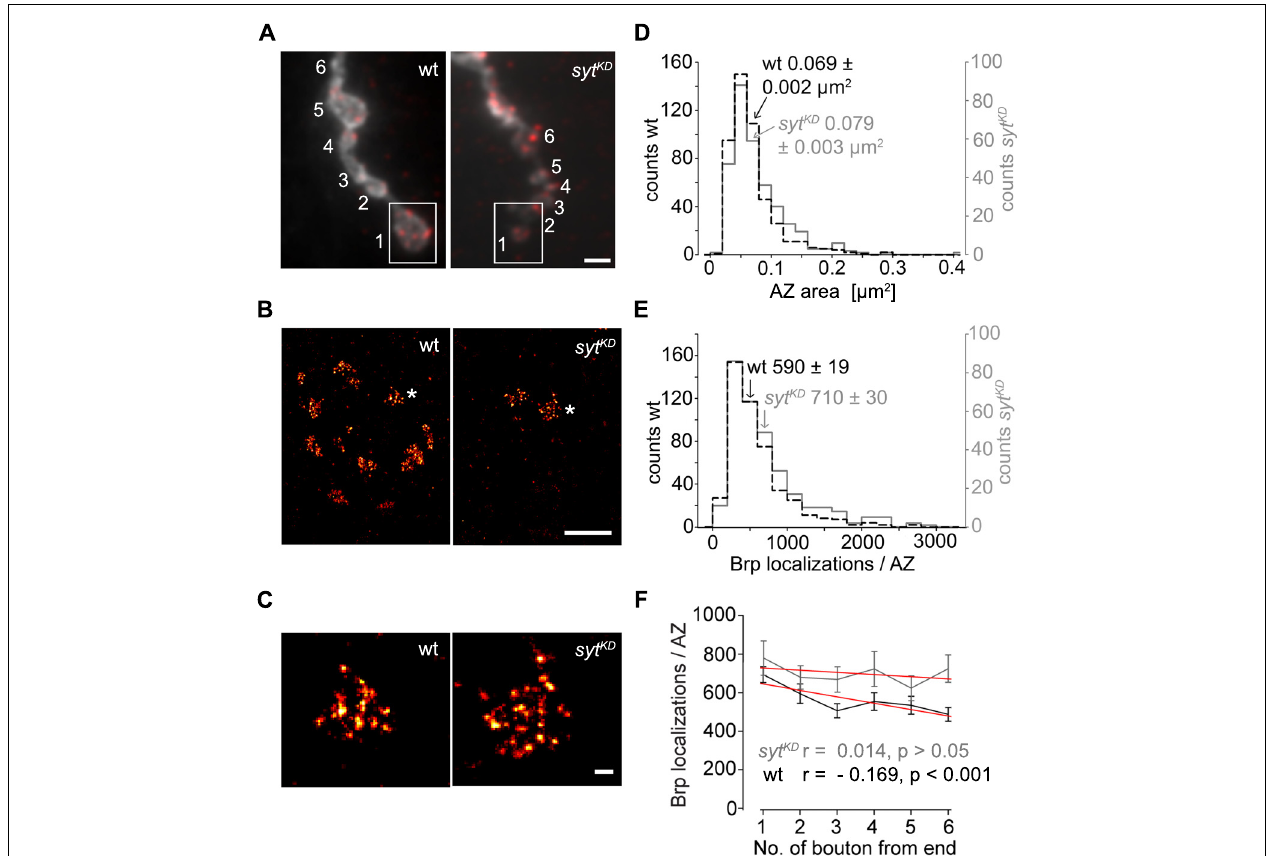
AZ areas and (E) distribution of Brp localizations per AZ are shifted to larger values in syt KD (gray). Arrows indicate respective mean ± SEM values. (F) Linear fits (red) of mean ± SEM Brp localizations per AZ in the terminal six type Ib boutons had slopes of –33.2 (wt) and –11.2 ( syt KD ) (non-parametric Spearman correlation coefficient wt: r = –0.169, p < 0.001; syt KD : r = 0.014, p > 0.05). Scale bars = 2 μ m (A) , 1 μ m (B) , 100 nm (C)